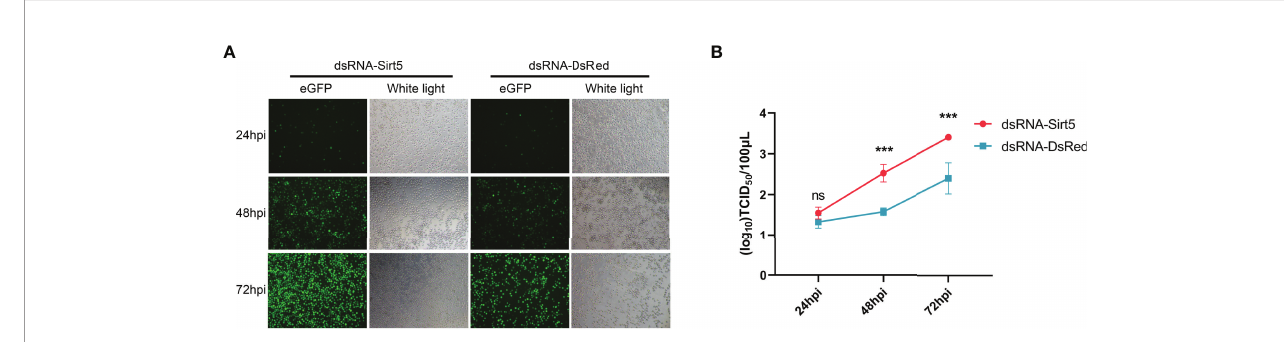
FIGURE 4 | Knockdown of BmSirt5 signi fi cantly promoted BmNPV replication in BmN cells. (A) Green fl uorescence images of BmNPV-eGFP infected cells observed by an inverted microscope (100×) at 24, 48 and 72 hpi. (B) Determination of viral titers in dsRNA-BmSirt5-transfected BmN cells at 24, 48 and 72 hpi. DsRNA of DsRed was used as a negative control. Each bar represents the mean ± SD. ***p < 0.001. ns, not signi fi cant.